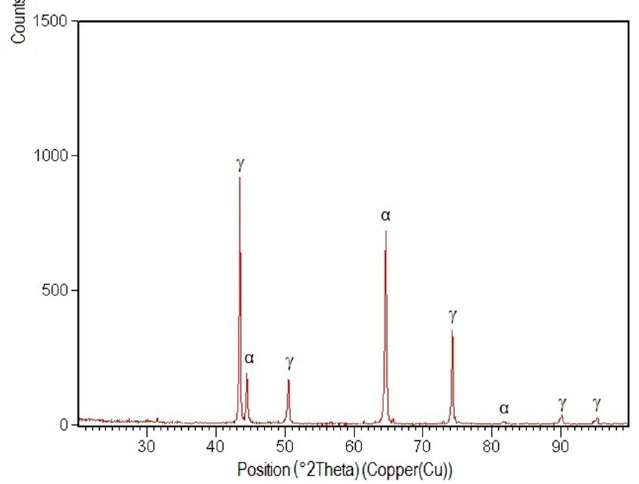
Figure 13. XRD pattern of the welded joint central zone E l = 15 kJ/cm.